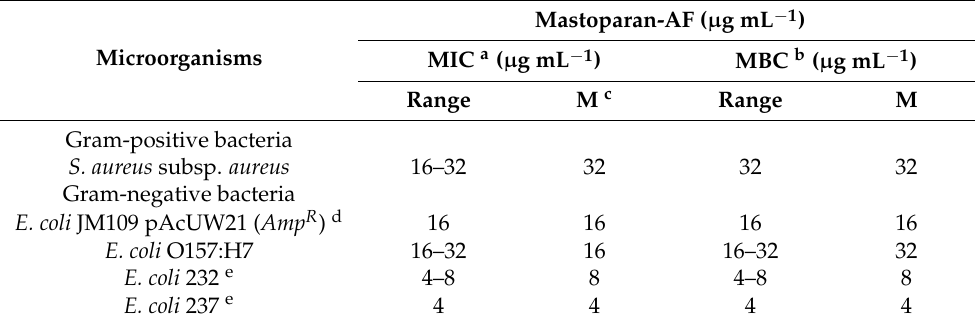
Table 1. Antibacterial activity of mastoparan-AF against Escherichia coli O157:H7, E. coli clinical isolates, and Staphylococcus aureus subsp. aureus